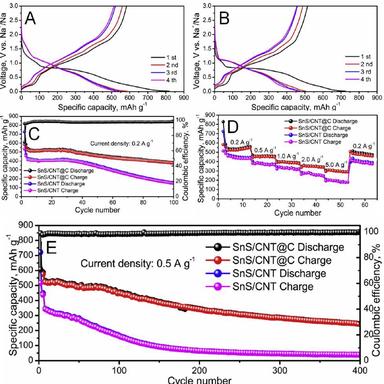
Electrochemical performance for SIBs: (A, B) Charge and discharge curves of SnS/CNT@C and SnS/CNT composite; (C) Cycle performance of SnS/CNT@C and SnS/CNT composite at 0.2 A g1 ; (D) Rate performance of SnS/CNT@C and SnS/CNT composite; (E) Long-term cycling performance of SnS/CNT@C and SnS/CNT composite at 0.5 A g1 .